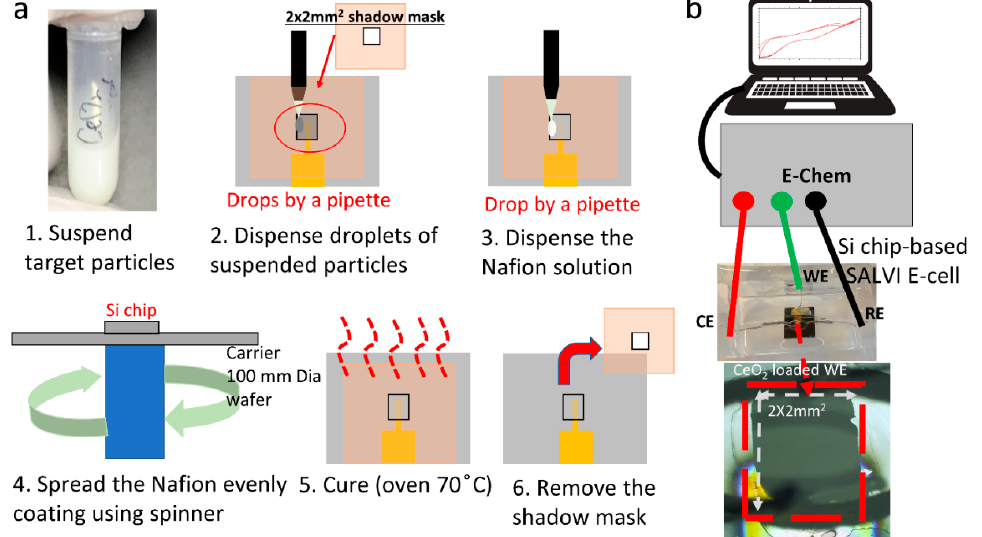
Figure 1. ( a ) The flow chart of the step-by-step fabrication process of particle deposition (1–3), Nafion film formation (4–5), and the assembled electrochemical device (6); and ( b ) the setup to perform electrochemical analysis of CeO 2 containing SALVI E-cells.